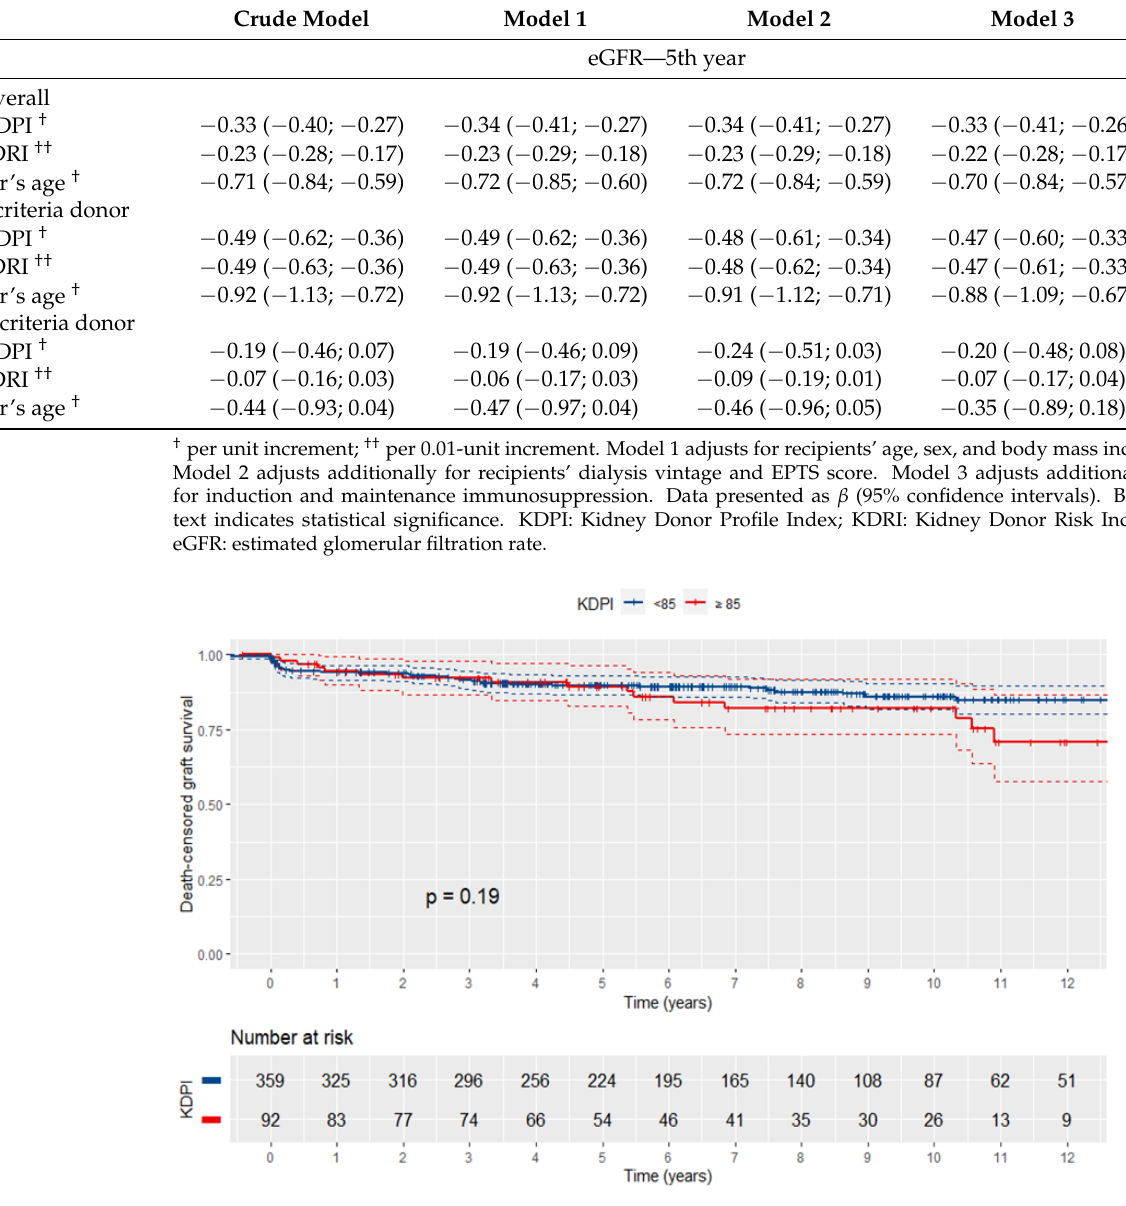
Figure 3. Kaplan–Meier curves of death-censored graft survival in patients with high and low KDPI. No signi fi cant di ff erence was observed using the KDPI cut-o ff of 85. Table 3. Cox proportional hazards regression analysis evaluating the e ff ects of KDPI, KDRI, and donor’s age on death-censored graft survival.